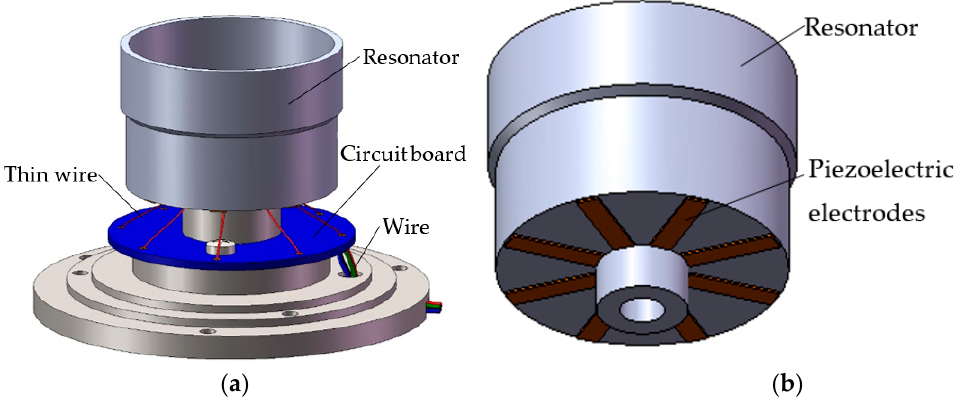
Figure 1. Configuration of cylindrical shell gyroscope. ( a ) Gyroscope; ( b ) Resonator.